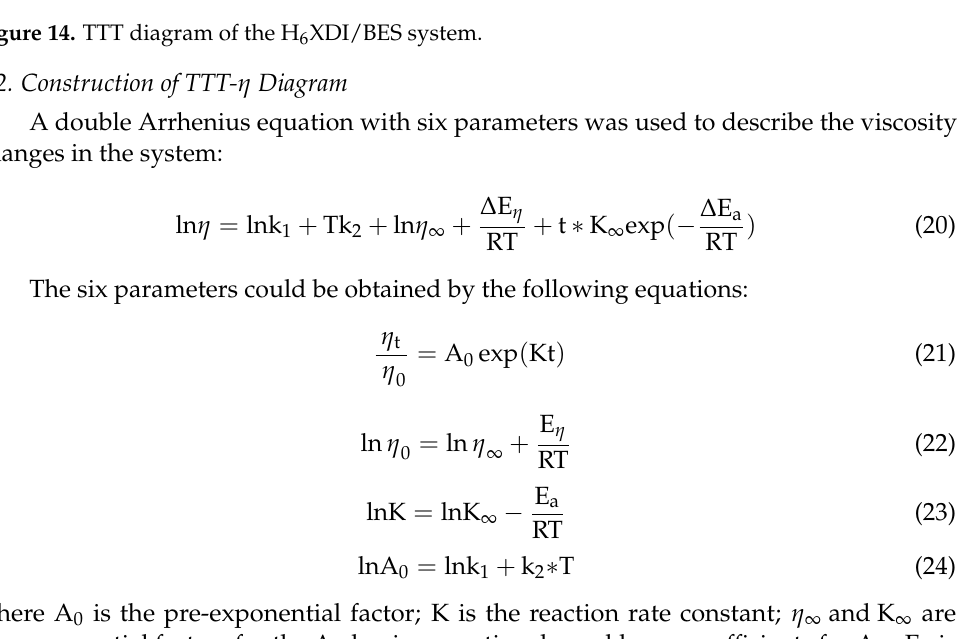
6 XDI/BES system.